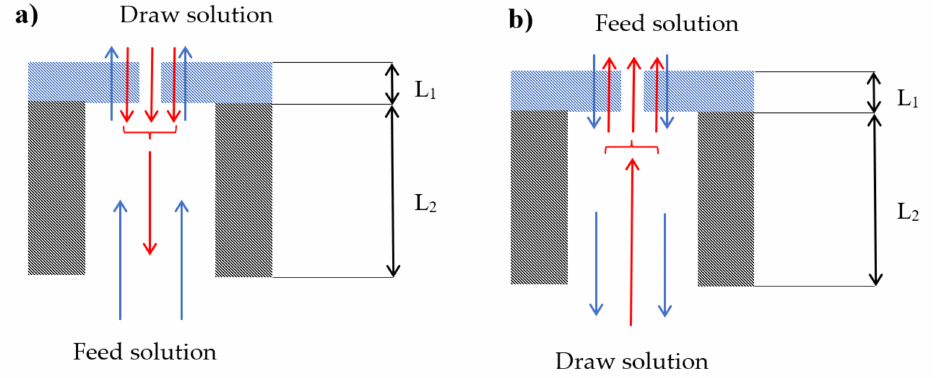
Figure 5. Schematic representation of TFC membrane and the transport of water and salt in ( a ) AL-DS orientation and ( b ) AL-FS